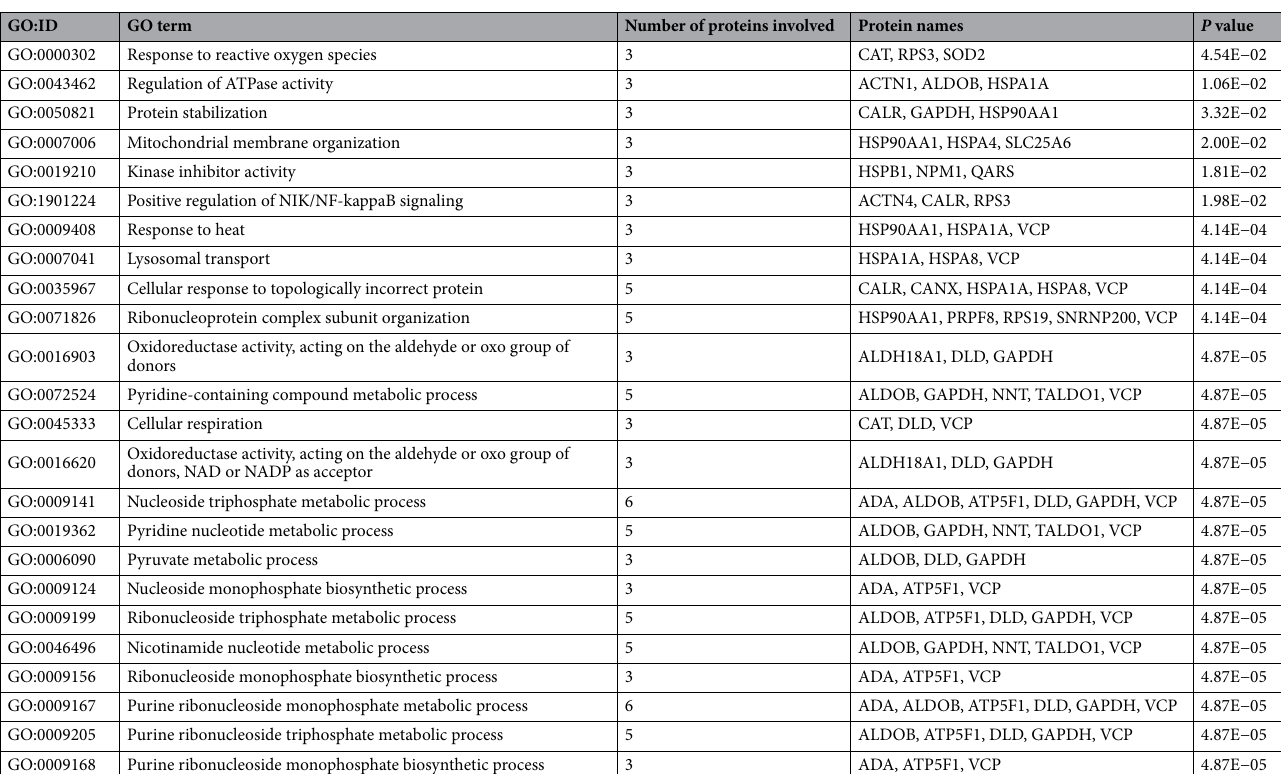
Table 3. Leading terms of enriched Gene Ontology biological process (GO) with ClueGO classification program and differentially expressed jejununal mucosa proteins of heat stress vs pair-fed dairy cows. P value was calculated according to a hypergeometric test and corrected with Bonferroni stepdown in the ClueGo